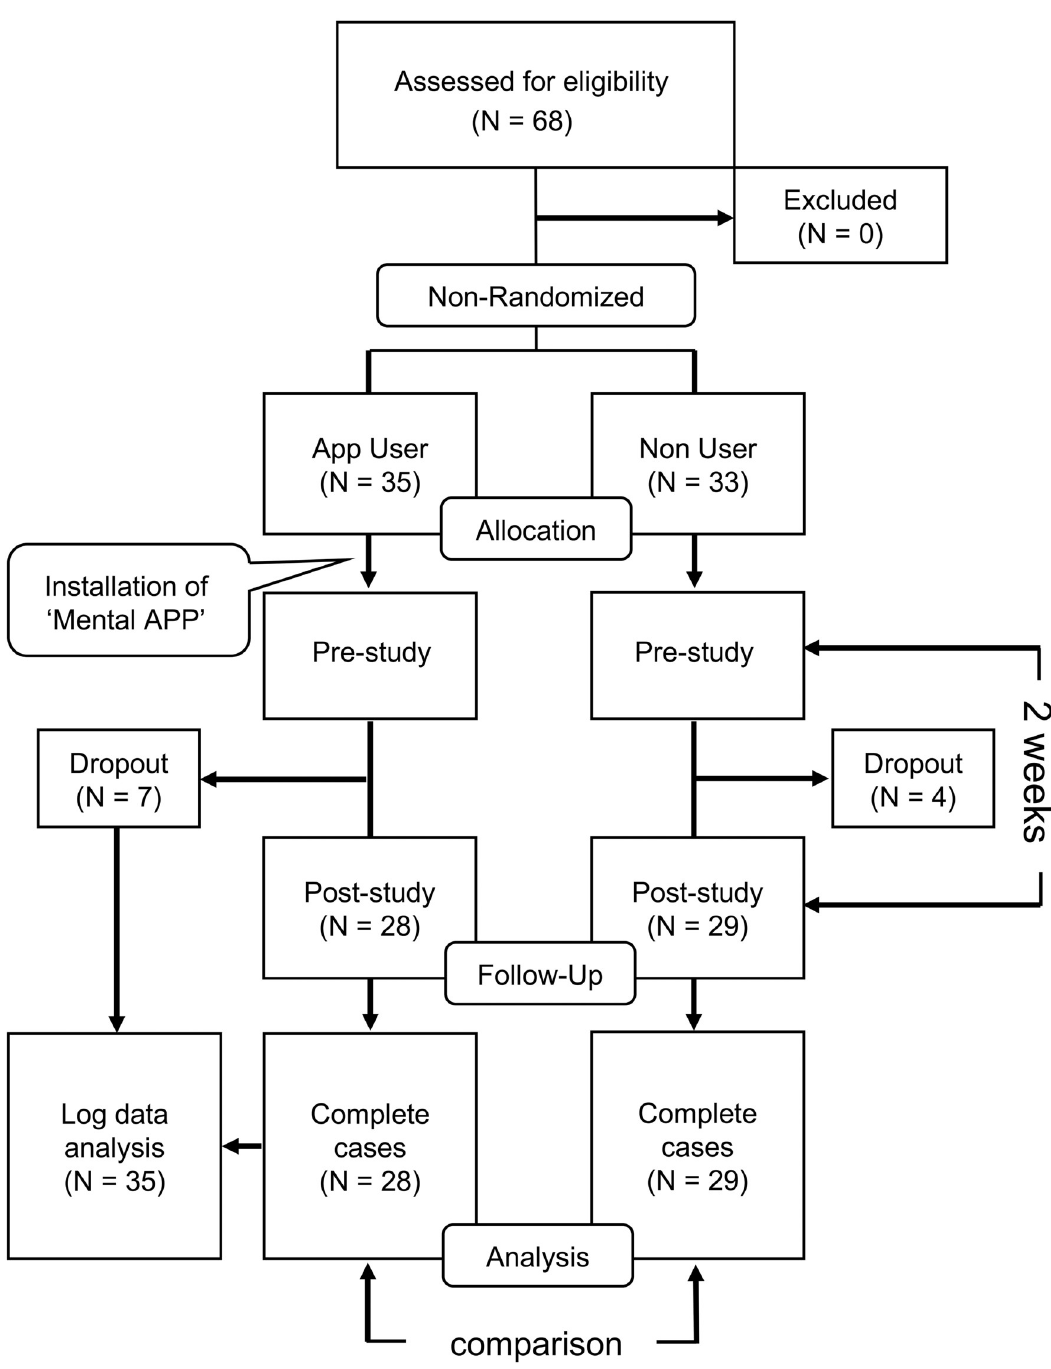
Fig 1. Flowchart of the recruitment process and the study